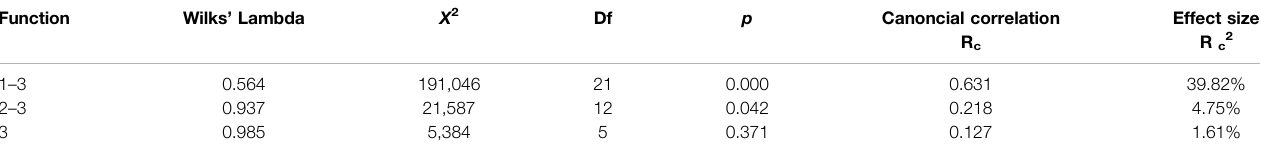
TABLE 5 | Means, standard deviations, and multiple analysis of variance between-group effects for TRIQ object-speci fi c (IL) subscales by interest phase. TRIQ subscale